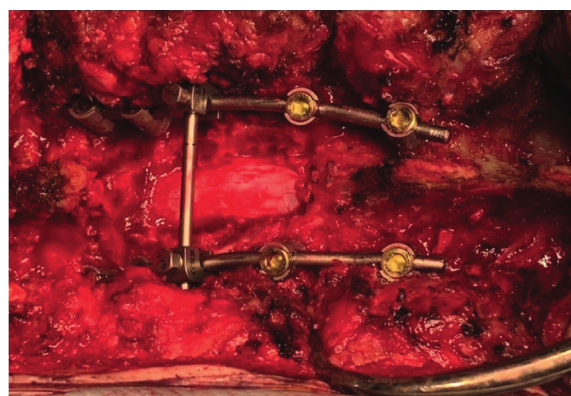
Figure 3: Intraoperative picture revealed the good decompression of the spinal